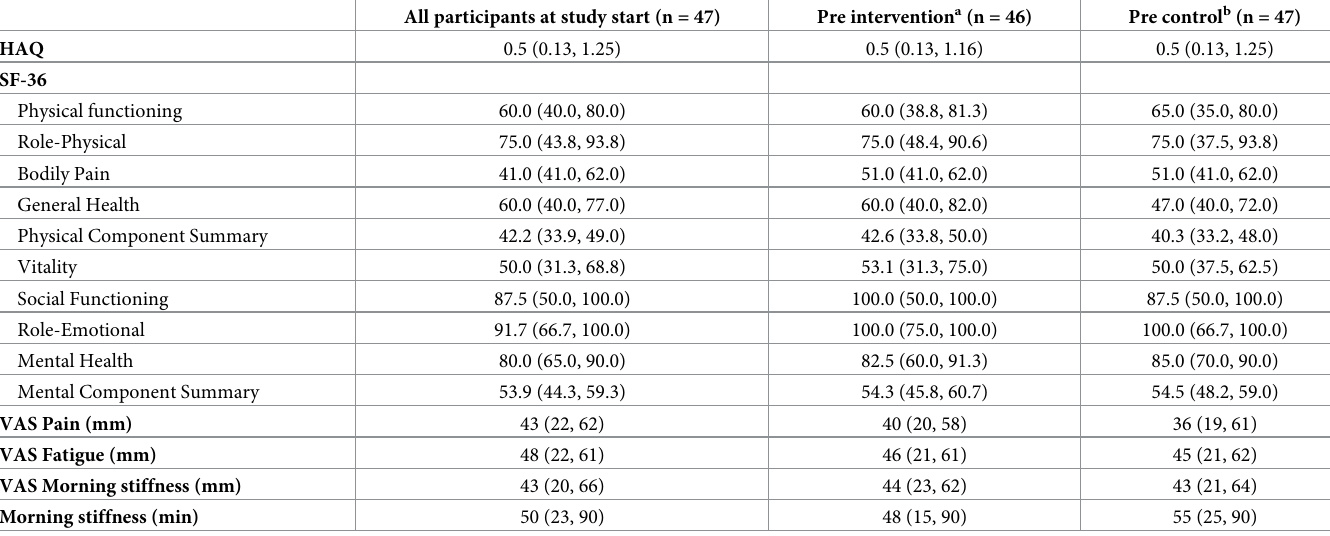
Table 2. HrQoL at baseline in the ADIRA